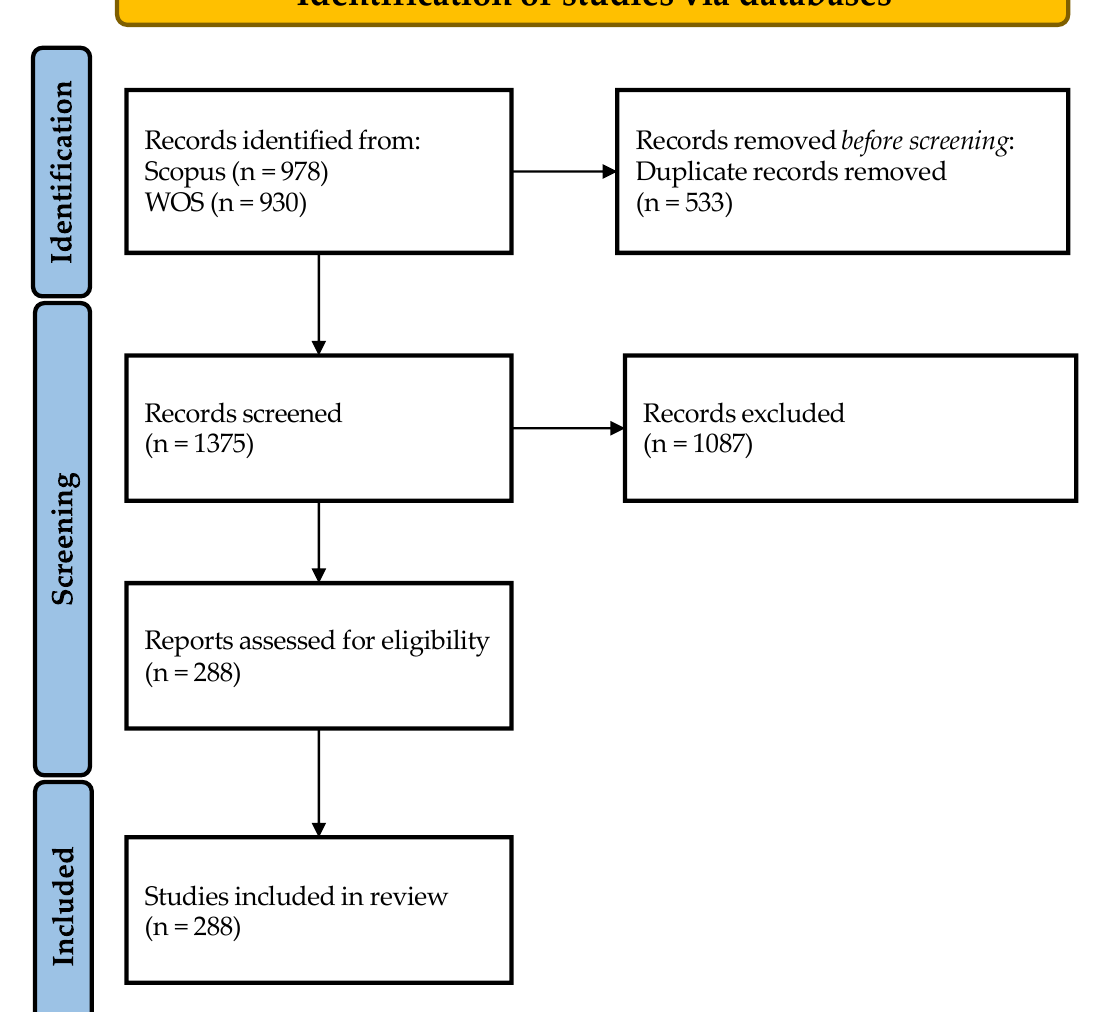
Figure 1. The PRISMA flow chart for the proposed literature review.